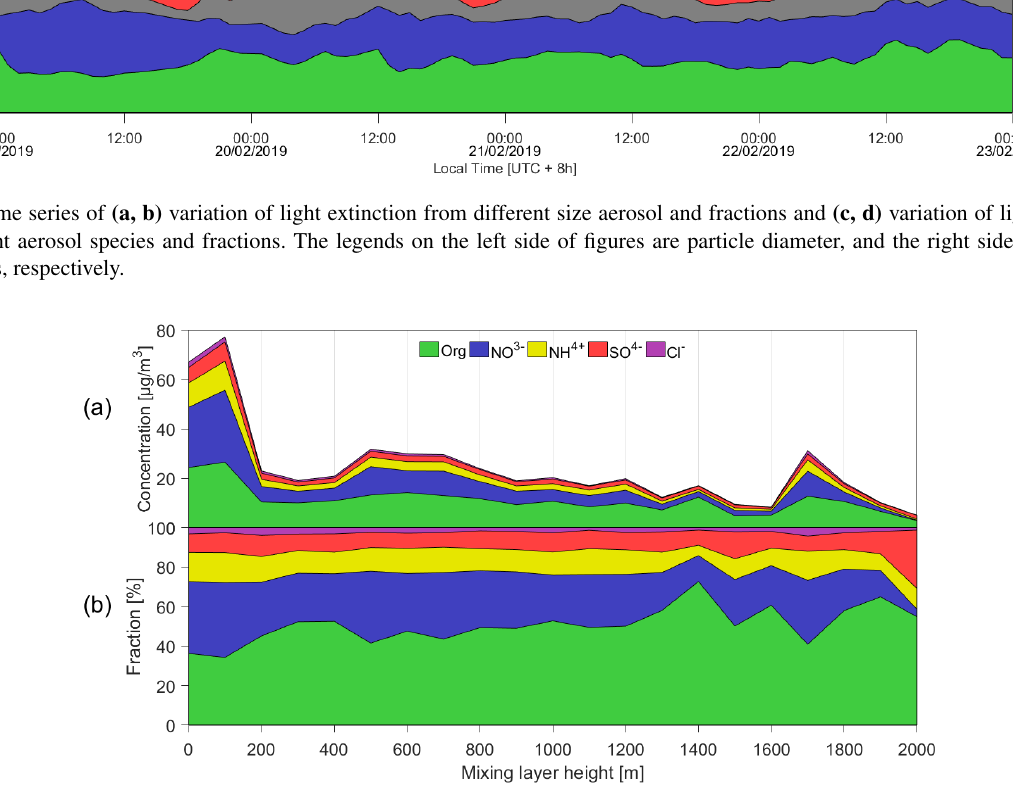
Figure 4. Statistical relationship between MLH and concentration (a) and fraction (b) of chemical composition species. Only daytime conditions determined by ceilometer from non-rainy periods (RH < 95%) during the observation ( ∼ 6 months) are